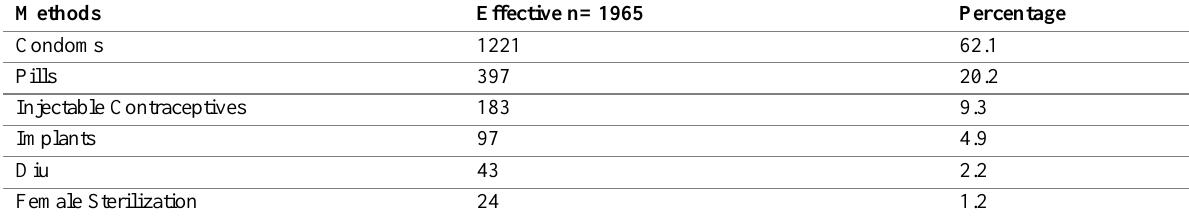
Table 3: Modern contraceptive methods known to women in